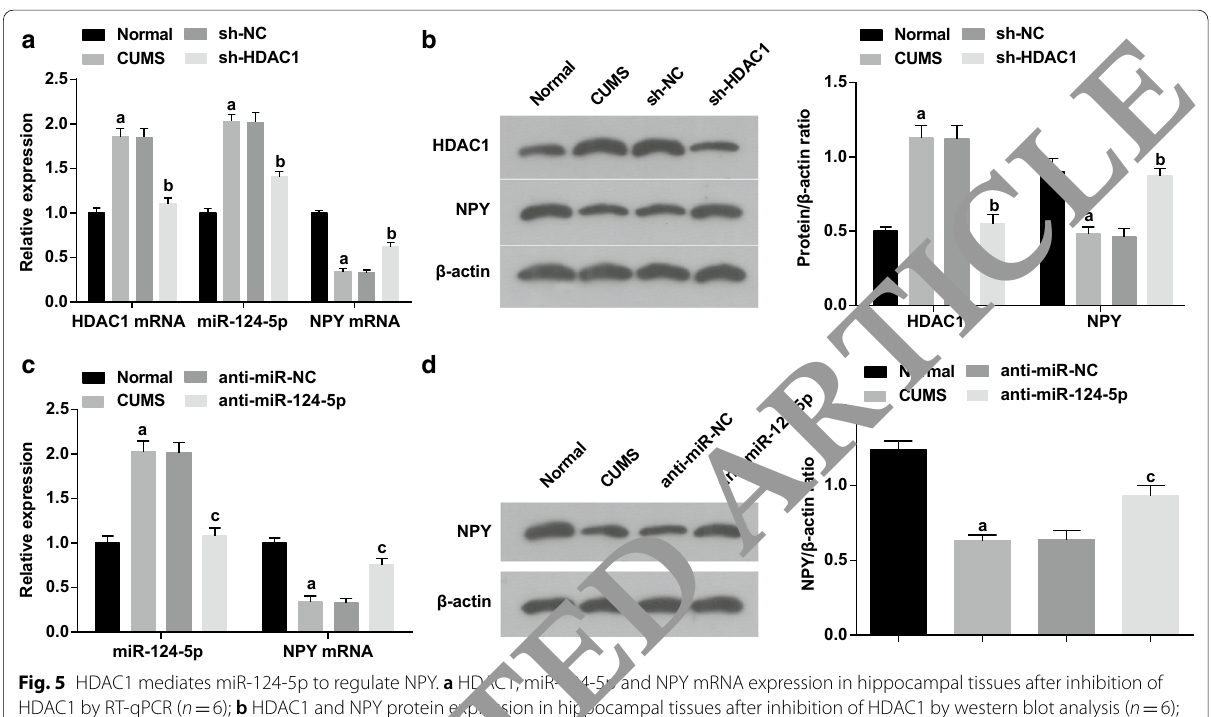
Fig. 5 HDAC1 mediates miR-124-5p to regulate NPY. a HDAC1, miR-124-5p and NPY mRNA expression in hippocampal tissues after inhibition of HDAC1 by RT-qPCR ( n 6); b HDAC1 and NPY protein expression in hippocampal tissues after inhibition of HDAC1 by western blot analysis ( n 6); = = c MiR-124-5p and NPY mRNA expression in hippocampal tissues after inhibition of miR-124-5p by RT-qPCR ( n 6); d NPY protein expression in = hippocampal tissues after inhibition of miR-124-5p by western blot analysis ( n 6); a P < 0.05 compared with the normal group; c P < 0.05 compared = with the sh-NC group. Comparisons among multiple groups were evaluated by one-way ANOVA, and pairwise comparisons by Tukey’s post hoc test